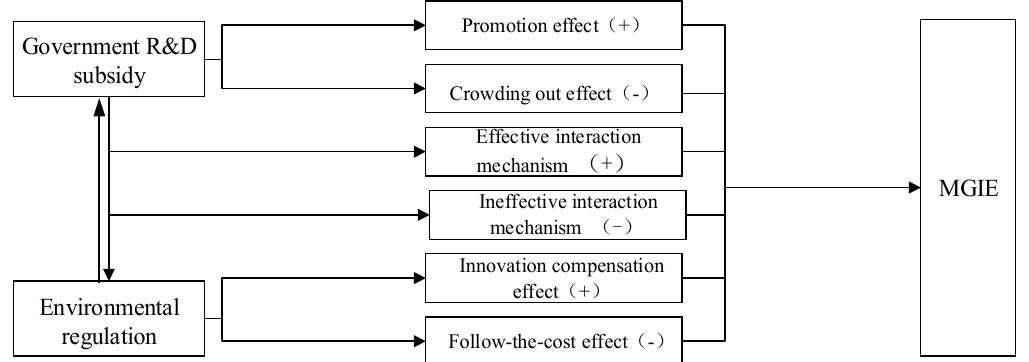
Figure 1. Mechanism of the effects of government Research and Development subsidies and environmental regulation on manufacturing green innovation efficiency (MGIE). Note: ‘ − , +’ represent negative and positive correlation, respectively, between R&D subsidies, environmental regulation, the interactive term of the two, and MGIE.